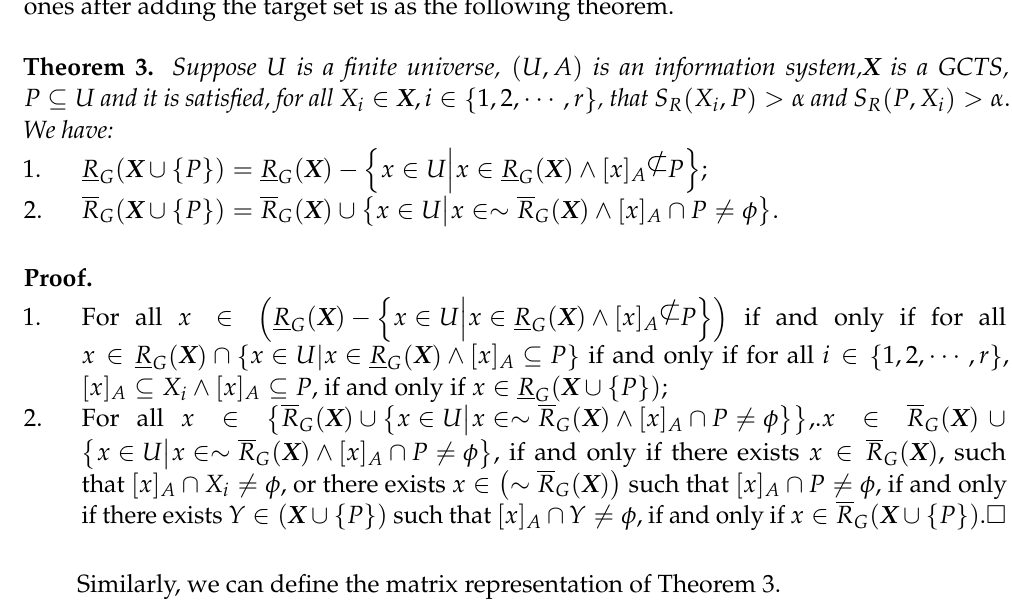
Table 1. An example of multi-label